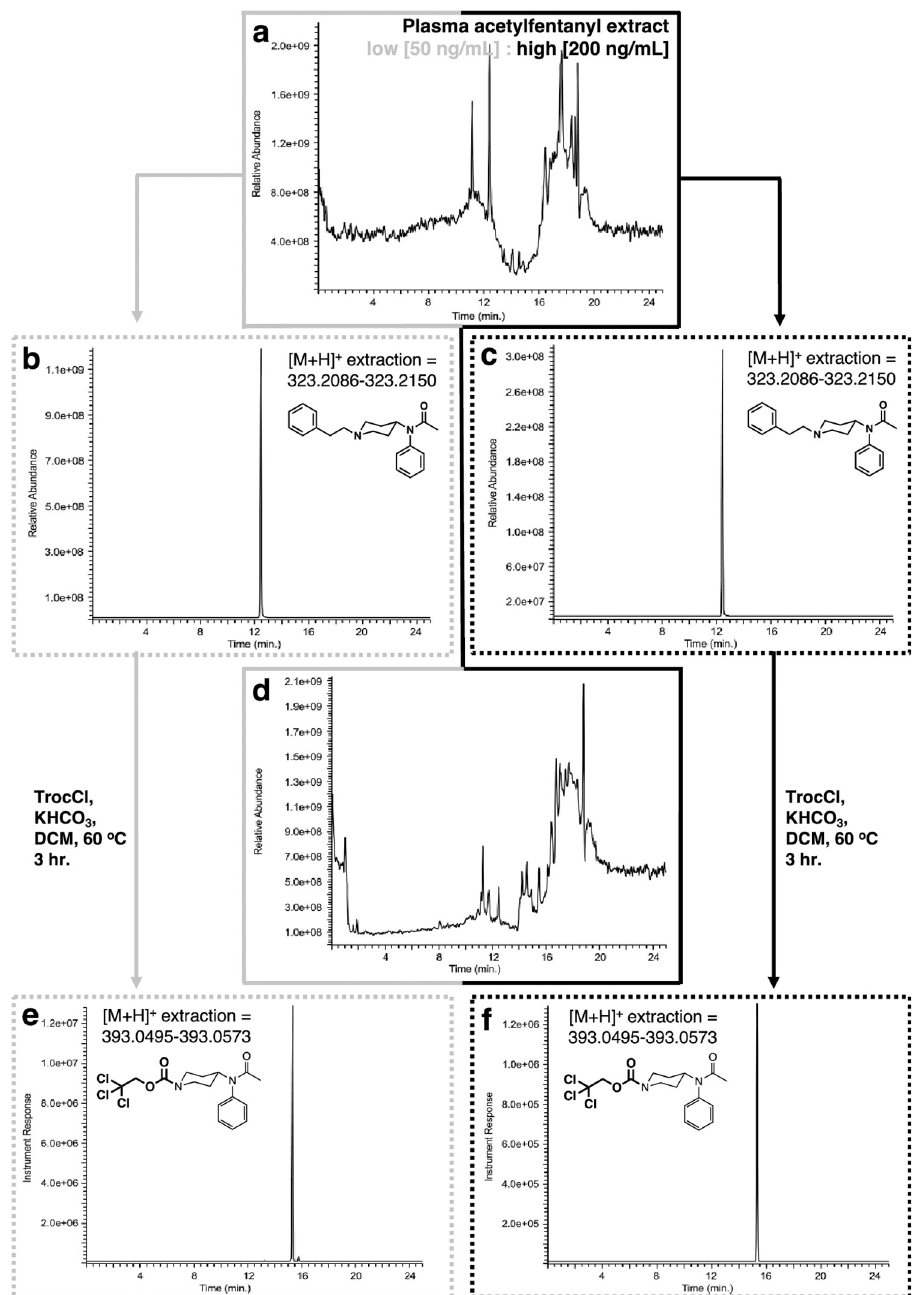
Fig 13. Analysis by HR-LC-MS of extraction and reaction of acetylfentanyl with Troc-Cl when spiked in plasma. (a) Total ion chromatogram (TIC) of extracted plasma sample; (b) extracted ion ([M+H] + = 323.2118 ± 5 ppm) for acetylfentanyl (rt = 12.46 min.) for low concentration plasma sample (50 ng/mL); (c) extracted ion ([M+H] + = 323.2118 ± 5 ppm) for acetylfentanyl for high concentration plasma sample (200 ng/mL); (d) Total ion chromatogram (TIC) of the reaction of extracted urine sample with Troc-Cl; (e) extracted ion ([M+H + ] = 393.0534 ± 5 ppm) for Troc- norfentanyl for low concentration spiked plasma sample; (f) extracted ion ([M+H + ] = 393.0534 ± 5 ppm) for Troc- norfentanyl for the high concentration spiked plasma sample showing its appearance at rt = 15.42 min.